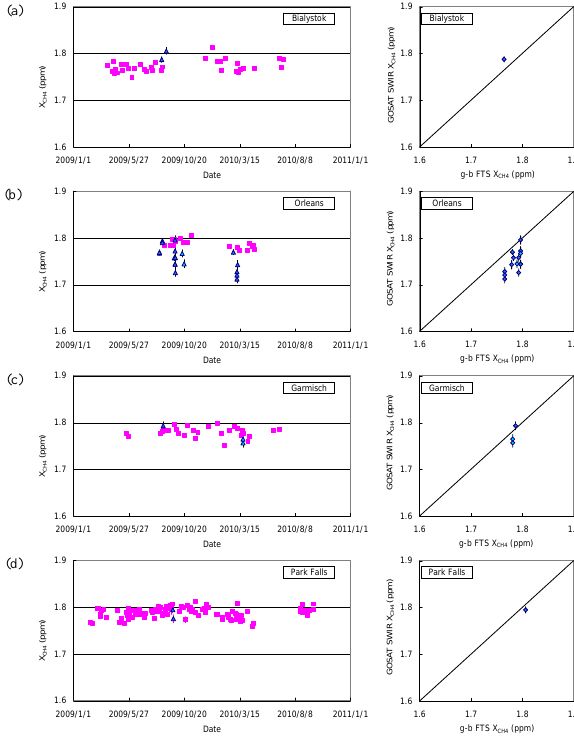
Fig.7. 5 Fig. 6. Time series of GOSAT TANSO-FTS SWIR (blue triangles) and g-b FTS (pink squares) X CH and their scatter diagrams for (a) 4 Bialystok, (b) Orl´eans, (c) Garmisch, (d) Park Falls, (e) Lamont, (f) Tsukuba, (g) Darwin, (h) Wollongong, and (i)